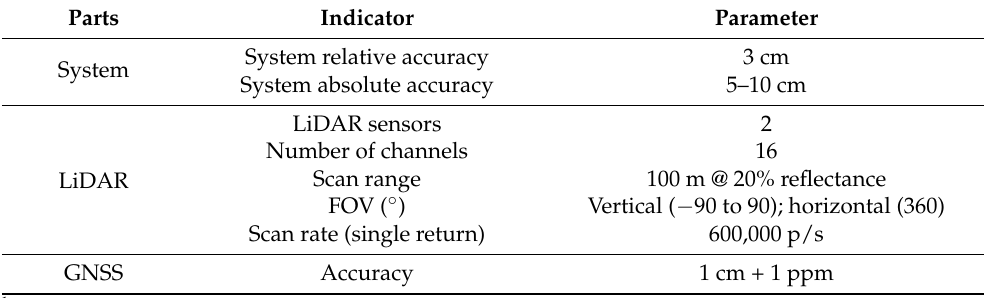
Table 1. LiBackpack DGC50 1 instrument parameters 2